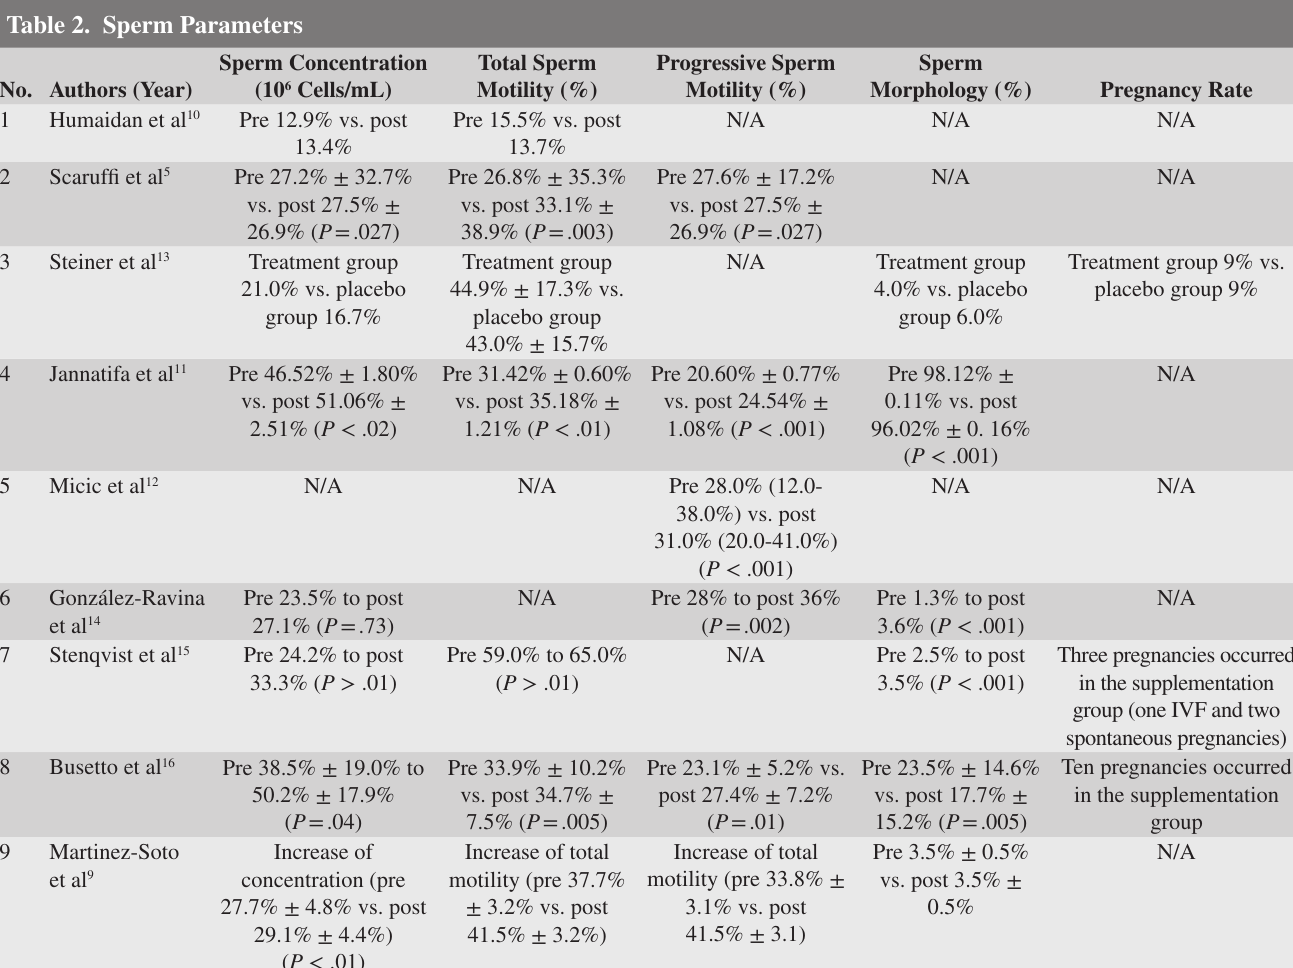
Table 2. Sperm Parameters